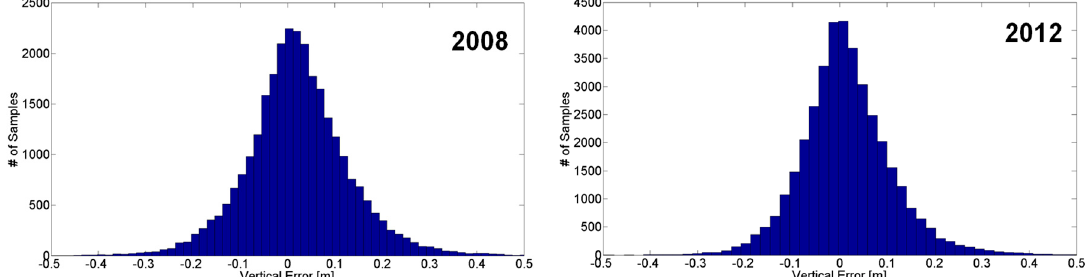
Figure 4. Vertical error distribution between the interpolated DEM and LiDAR point cloud for the six segments (see Figure 1) evaluated for the 2008 and 2012 datasets of SR 666.